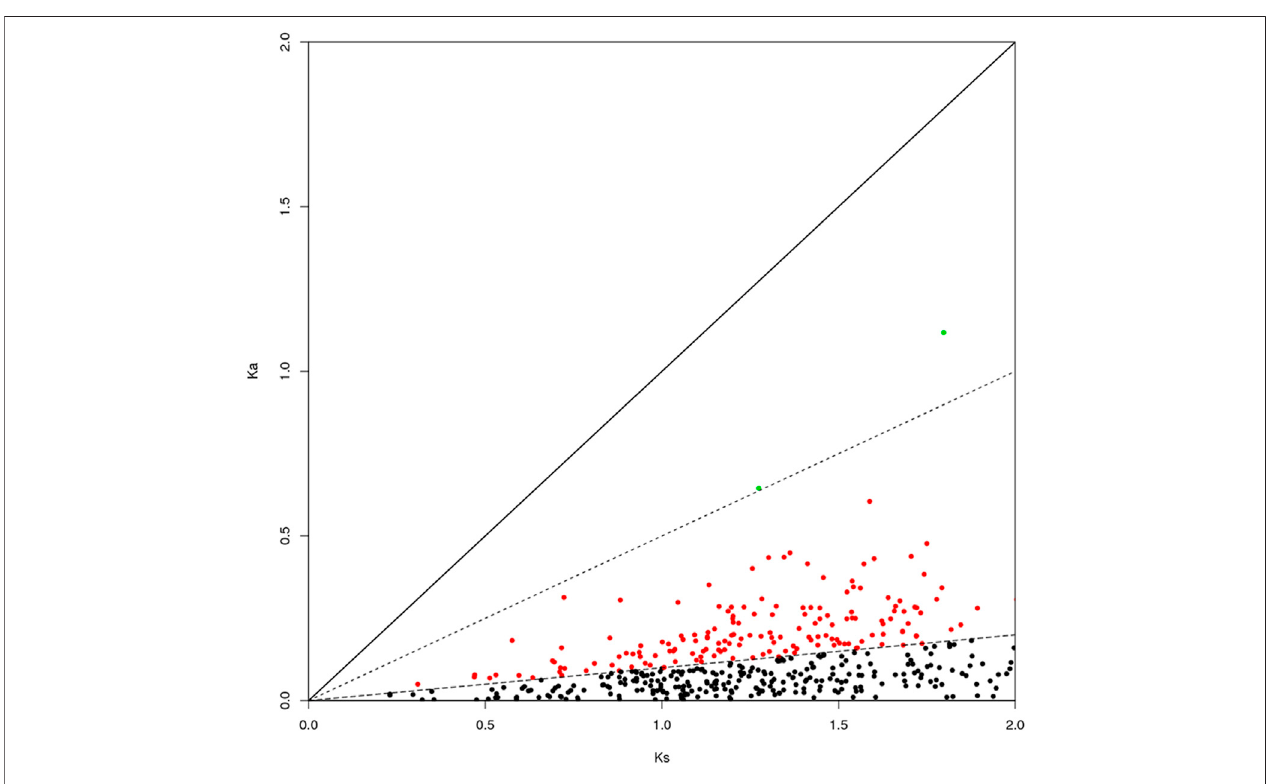
FIGURE 10 | Scatter plot of Ka/Ks obtained by comparing Bactrocera dorsalis (Hendel) and Ceratitis capitata (Wiedemann). Note: the region of blue spot: strong positive select genes; the region of green spot: weak positive selection genes; the region of black spot: puri fi cation selection genes.